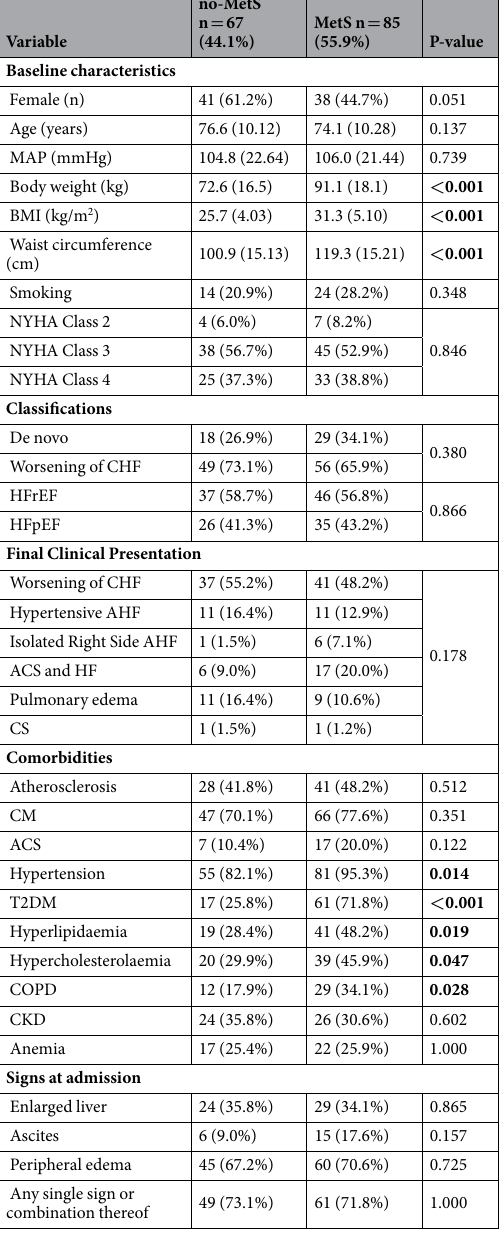
Table 1. Baseline characteristics, classification, comorbidities and signs at admission. Metric/continuous/ quantitative variables are presented as mean and standard deviation. For categorical/qualitative variables the absolute and relative frequencies are shown as n (%) and significant differences depicted in bold. ACS-Acute Coronary Syndrome; AHF-Acute Heart Failure; BMI-Body Mass Index; BW-Body Weight; CHF-Chronic Heart Failure; CKD-Chronic Kidney Disease, CM-Cardiomyopathy; COPD-Chronic Obstructive Pulmonary Disease; CS-Cardiogenic Shock; EF-Ejection Fraction; HFpEF-Heart Failure with preserved Ejection Fraction; MAP-Mean arterial pressure; HFrEF- Heart Failure with reduced Ejection Fraction; NYHA-New York Heart Association Functional Classification; T2DM-Type 2 Diabetes